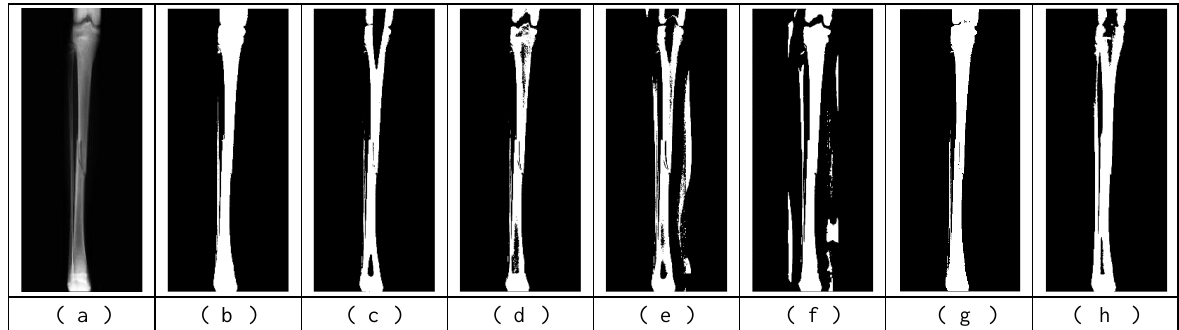
Figure 1. Comparison of segmentation methods. (a) A sample original image. (b) Image obtained after Otsu thresholding method. (c) Image obtained after active contour method, (d) Image obtained after K-means method. (e) Image obtained after fuzzy c-means method, (f) Image obtained after Niblack thresholding method. (g) Image obtained after MMTR. (h) Image obtained by the Expert.